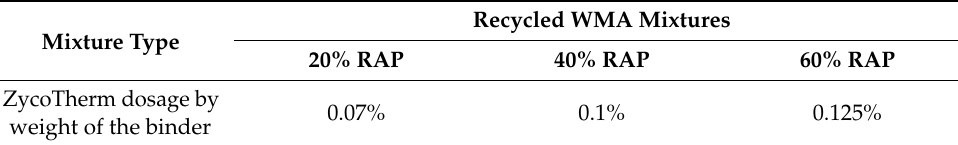
Figure 8. Aggregate-binder bonding in HMA and modified WMA mixtures [20]. ( A ) Aggregate- binder bonding in HMA; ( B ) Aggregate-binder bonding in WMA modified by ZycoTherm. Table 14. ZycoTherm dosage within the recycled WMA mixtures.